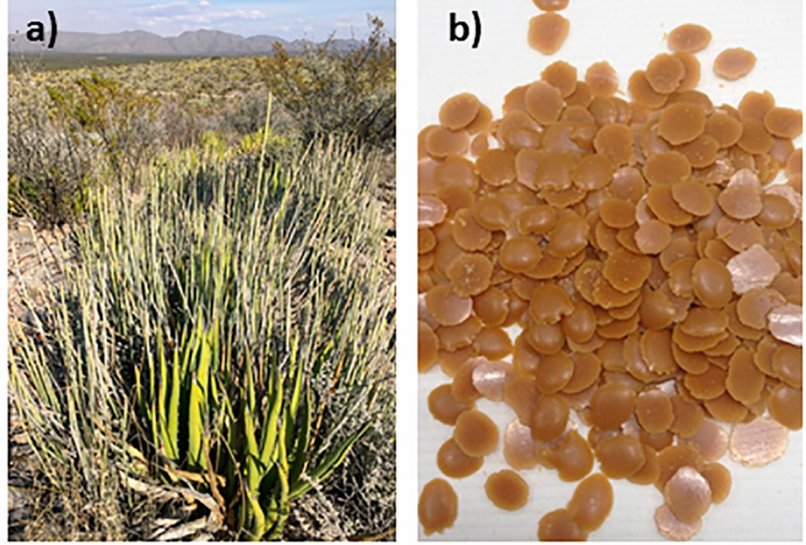
Figure 1. ( a ) Candelilla wild plant ( Euphorbia antisyphilitica ) grown in the northern Chihuahuan Desert; ( b ) candelilla wax pearls obtained after the extraction process in aqueous